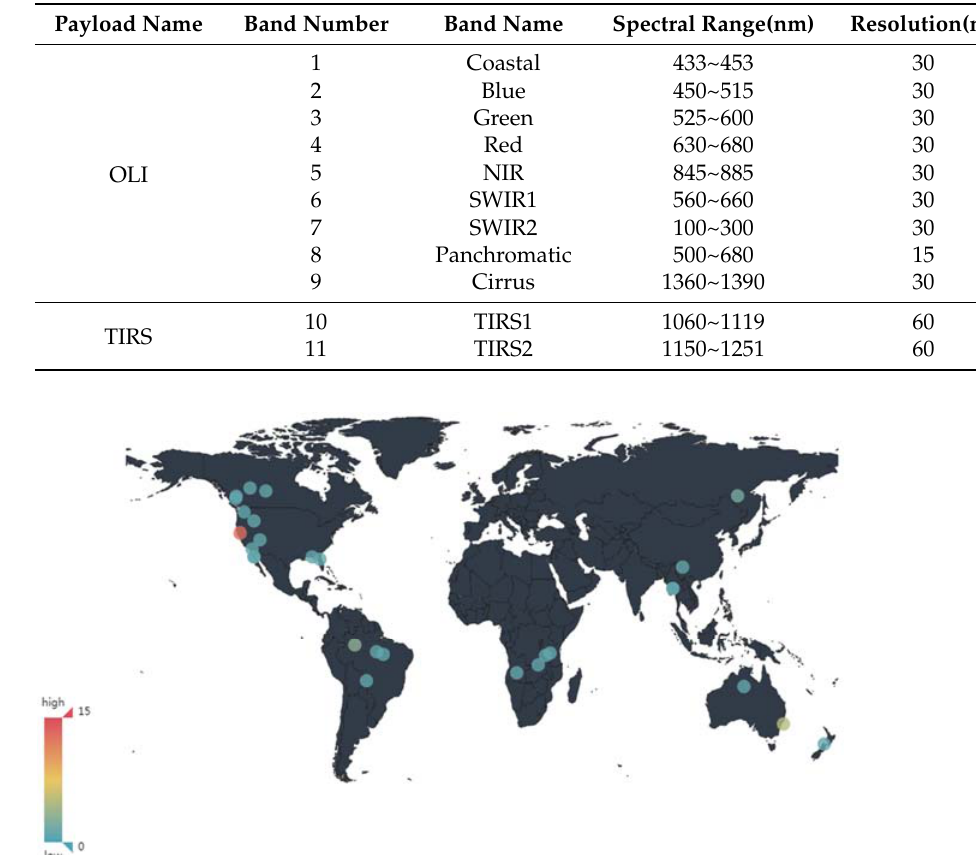
Table 1. Landsat-8 Satellite Parameters.